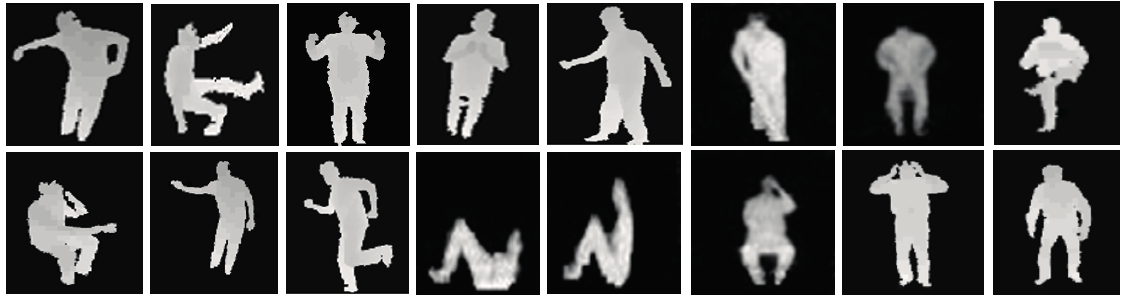
Figure 10. Sample frames from our proposed smart indoor activity datasets using three different environments (home, office, and hospital). Row-wise, from left: cooking, watching TV, exercise, hand clapping, walking, cleaning, sitting down, reading an article, phone conversation, presentation, rushing, lying down, getting up, taking medicine, headache, and vomiting.